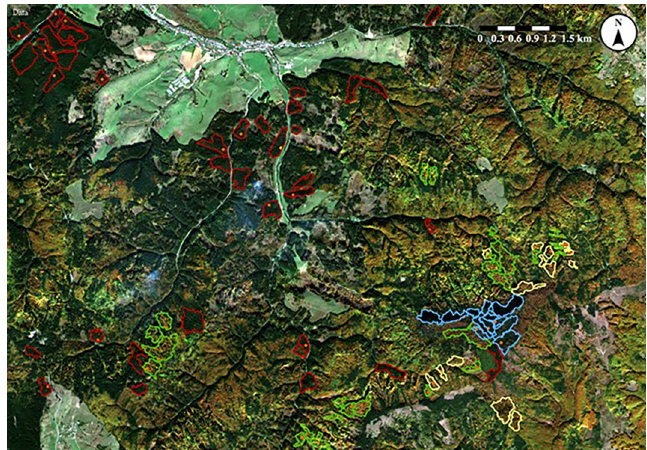
Figure 4. Part of the case study area in Čierny Balog with segments of habitats 9410 – Acidophilous Picea forests of the montane to alpine levels (blue); planted spruce forest (red); 9130 – Asperulo-Fagetum beech forests (yellow); and 9180 – Tilio-Acerion forests of slopes, screes, and ravines (green). Red dots are localities where relevés were sampled (created in software NaturaSat v1.2 31 , dataset from October 17, 2019; acquisition time 9:40:29, spatial resolution of Sentinel-2 satellite image is 10 m, 1 pixel on the satellite image represents 10 × 10 m on the Earth